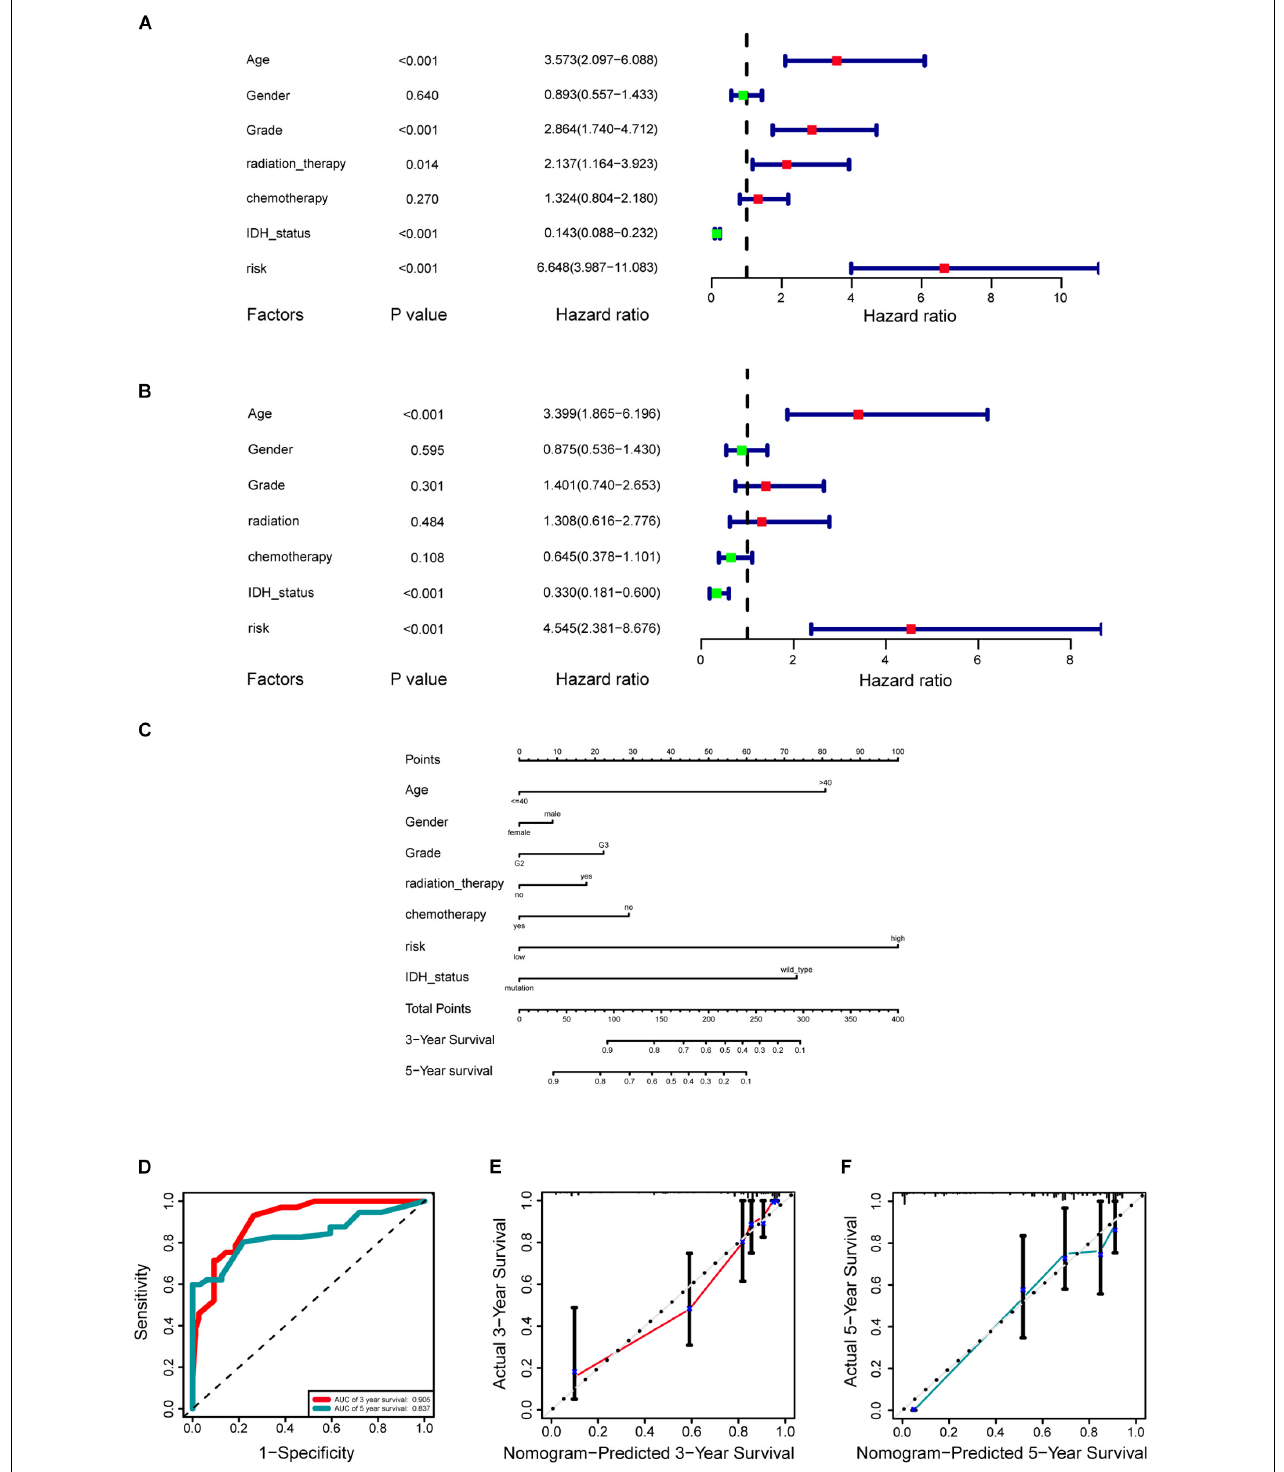
FIGURE 6 | Development of a prognostic stemness indices-related gene signature for primary low-grade glioma (LGG). (A) Univariable Cox regression analysis for the training cohort. (B) Multivariable Cox regression analysis for the training cohort. (C) A nomogram including risk score and other clinical features for predicting 3- and 5-years overall survival (OS) of primary LGG. (D) Time-dependent receiver operating characteristics (ROC) curve analysis for 3- and 5-years OS predictions for the nomogram compared with actual observations. Calibration plot of nomogram for predicting probabilities of 3- (E) and 5-year (F) OS of primary LGG patients in the TCGA